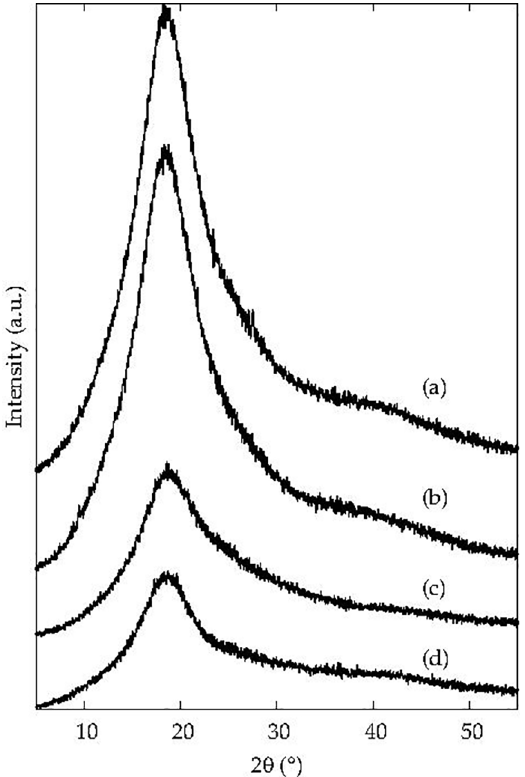
Figure 2. X-ray diffractograms of latex membranes M4 and M3 and M1 and M2 prepared using the deposition technique and Van Gogh method,